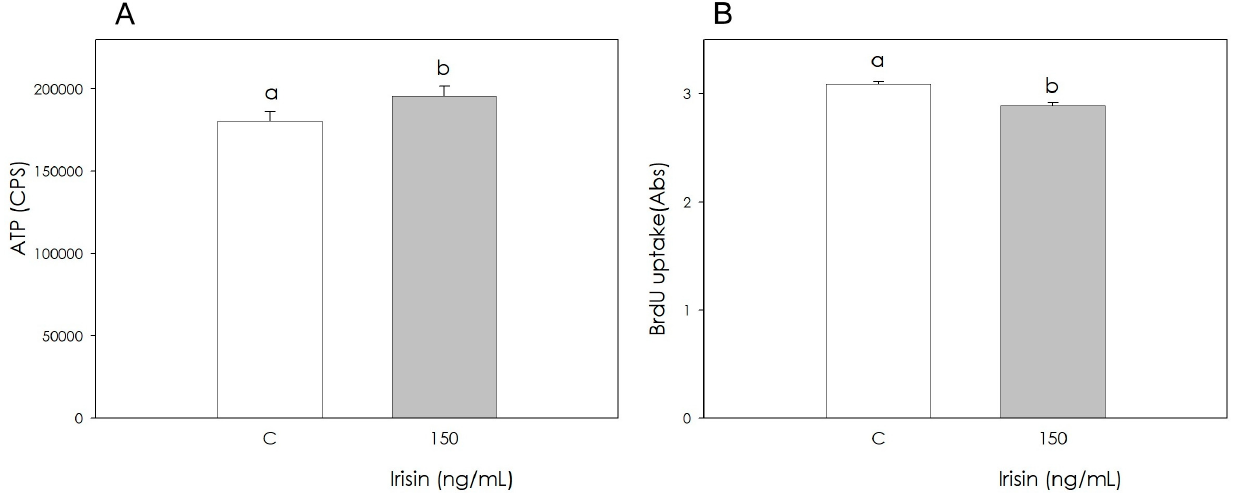
Figure 2. Effect of the treatment with Irisin (150 ng/mL) for 48 h on swine adipose stromal cell metabolic activity ( A ) measuring ATP production and proliferation (B) using 5-bromo-2 ′ -deoxyuridine (BrdU) incorporation assay test. Data, expressed as count per second (CPS) ( A ) or milliAbsorbance (mAbs) units ( B ), represent the mean ± SEM of six replicates/treatment repeated in five different experiments. Different letters on the bars indicate a significant difference ( p < 0.05) among treatments as calculated by ANOVA and the Scheffè’ F test.